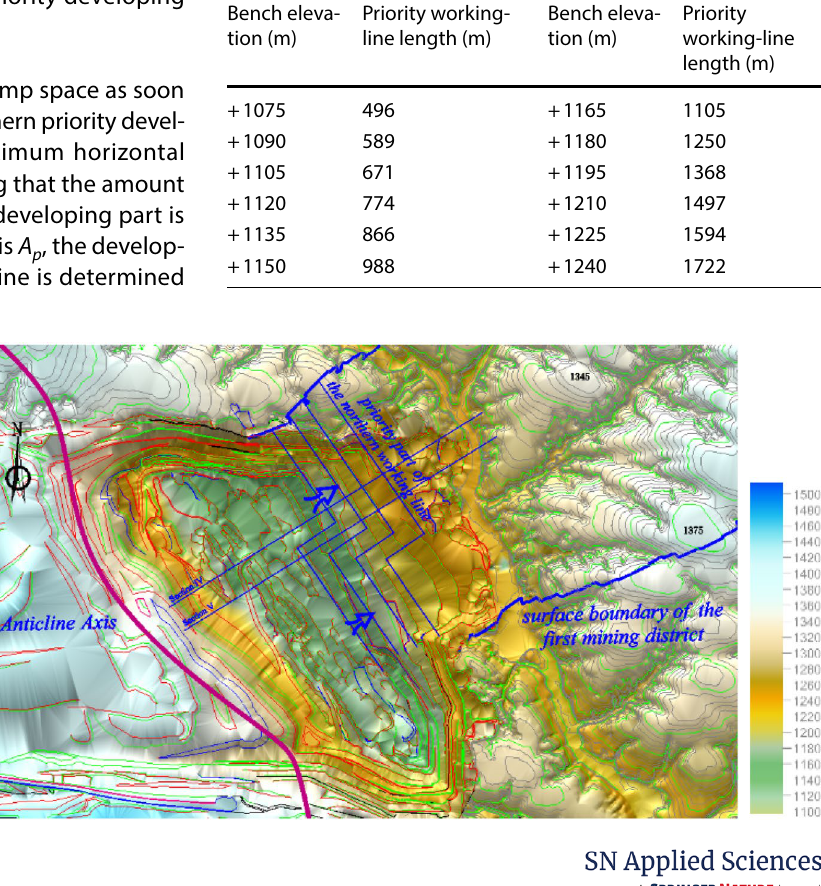
Table 3 Length of northern priority working line in Luzigou anti- cline region Bench eleva- tion